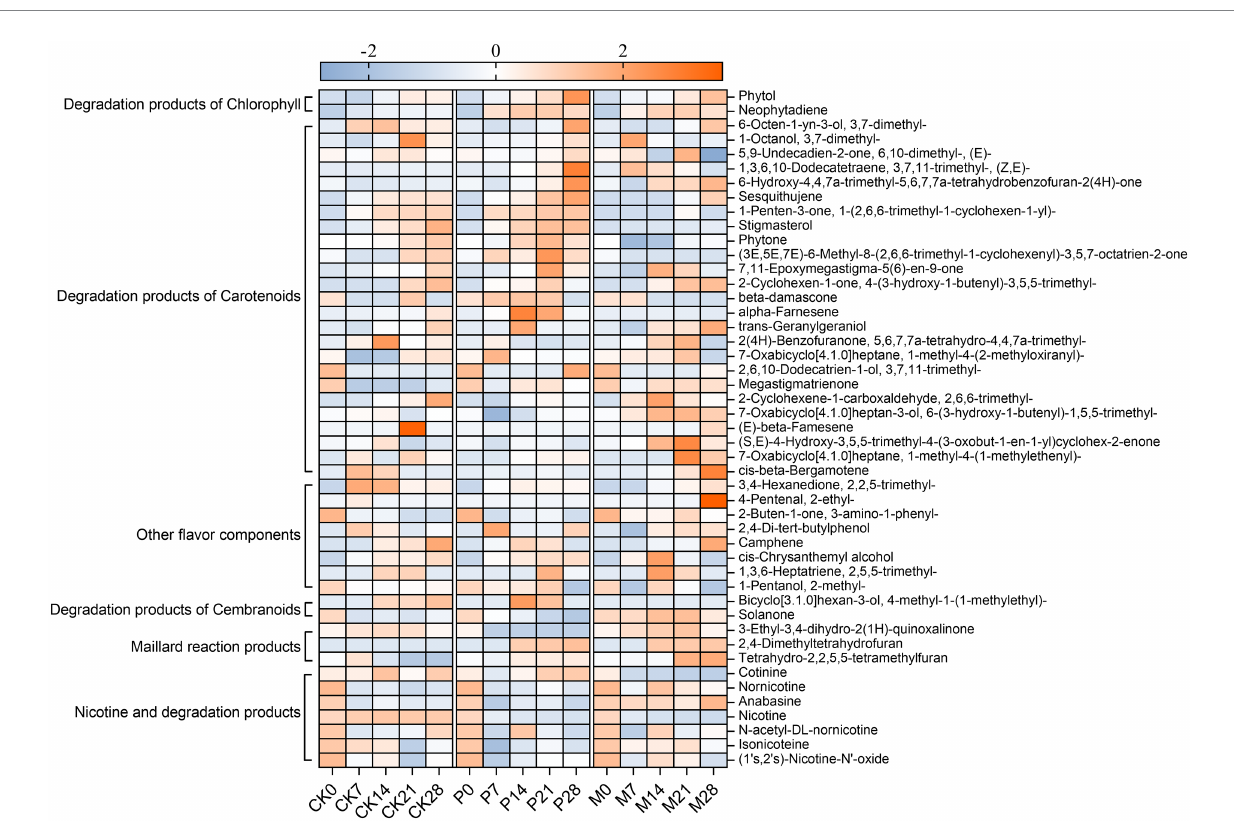
FIGURE 5 Change in the contents of flavor compounds and alkaloids during bioaugmentation fermentation of Candida strains. The peak area of each compound was normalized using Z-score. The color intensity was proportional to the concentration of compounds. CK0-CK28: Control group; P0-P28: C. parapsilosis group; M0-M28: C. metapsilosis group, and the numbers 0, 7, 14, 21, 28 indicated the fermentation